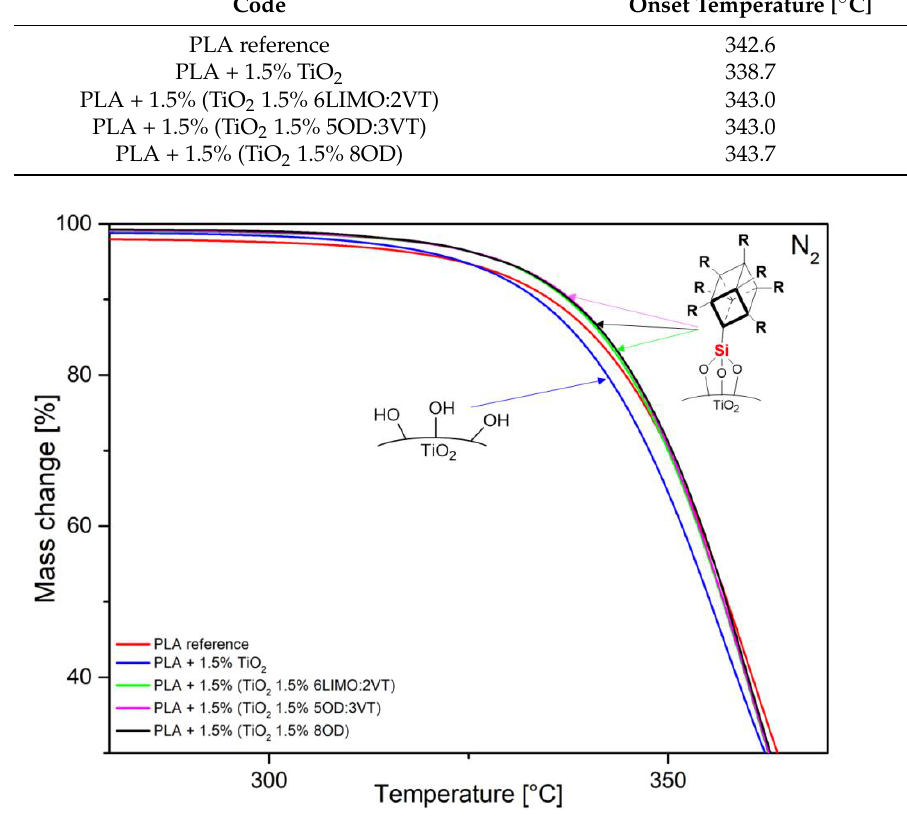
Figure 2. TGA curves under nitrogen atmosphere.